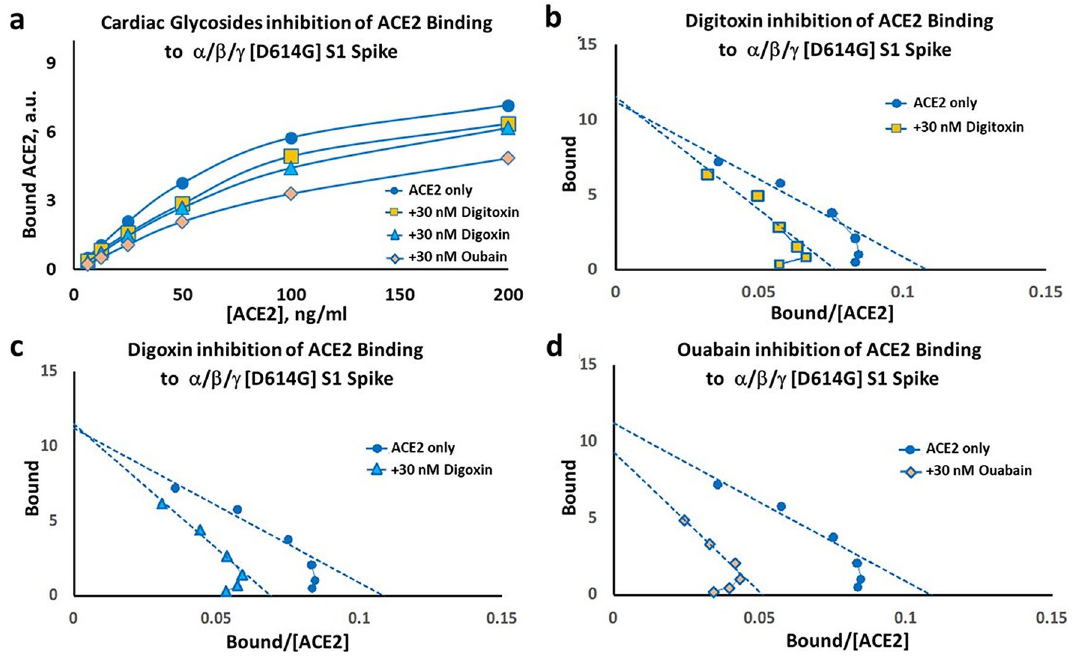
Figure 6. Inhibition of ACE2 binding to the α/β/γ [D614G] S1 spike by cardiac glycoside drugs. ( a ) Substrate- Binding plots for inhibition by digitoxin, digoxin and ouabain (30 nM). ( b – d ) Eadie–Hoffstee plots of data in Part ( a ) for ( b ) digitoxin inhibition; ( c ) digoxin inhibition; and ( d ) ouabain inhibition. Each point is the average ± SE for N = 5–6 independent experiments.